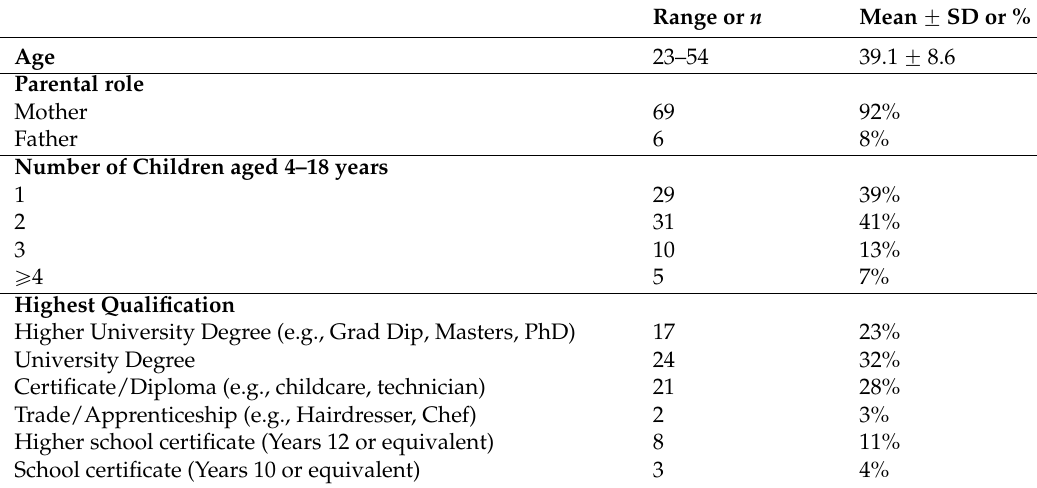
Table 1. Demographics of participants ( n = 75) and their